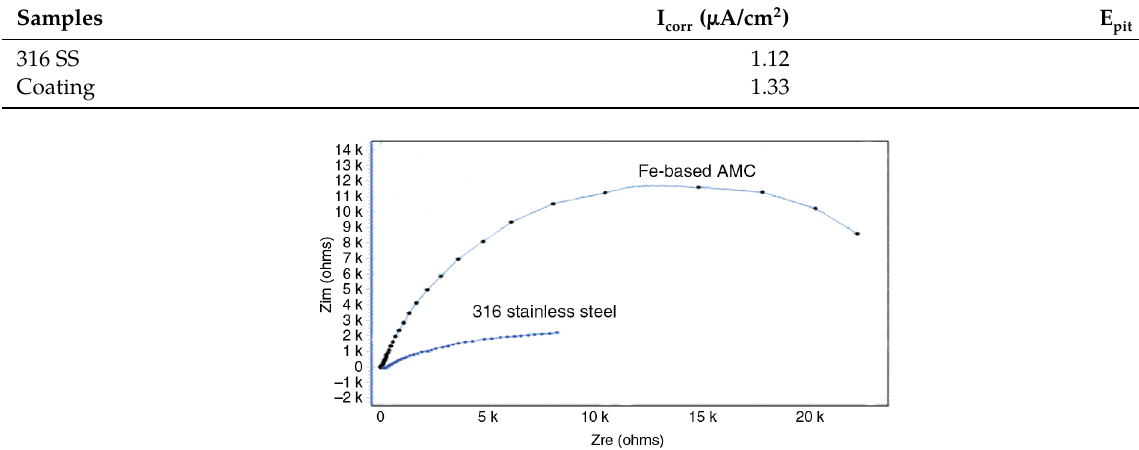
) and pitting potentials (E corr